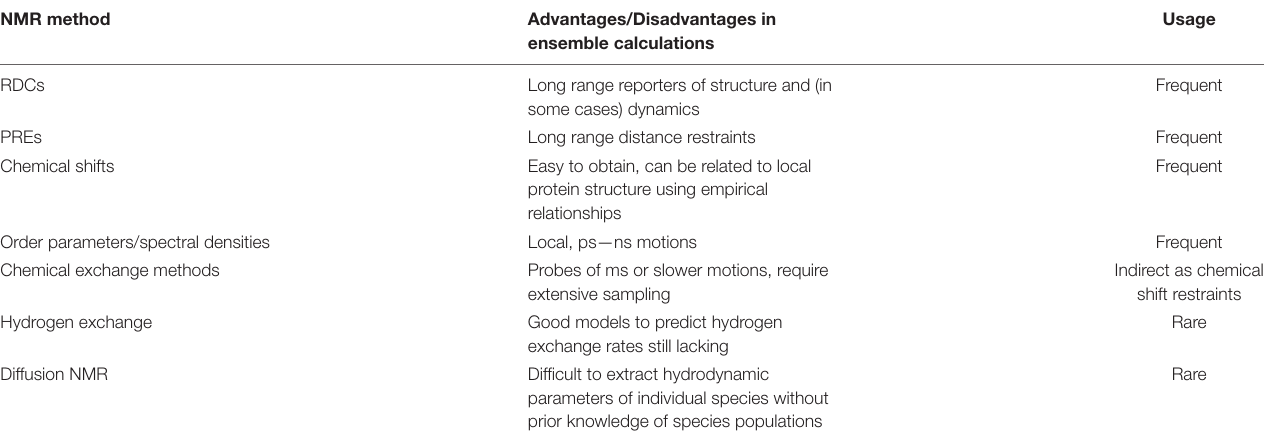
TABLE 1 | NMR methods and their usage in ensemble